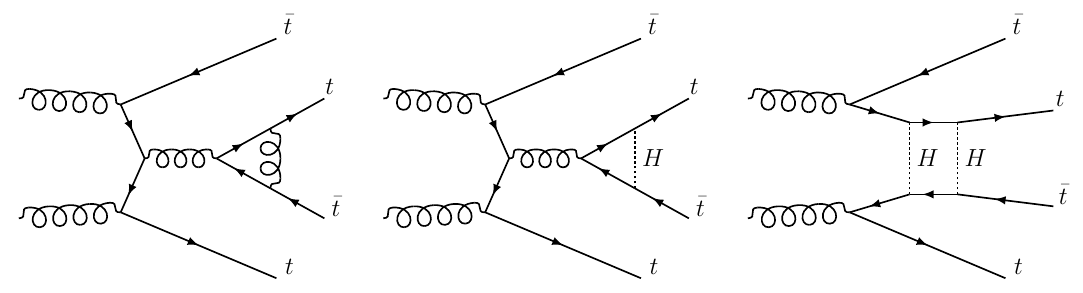
Figure 4 . Representative diagrams for the one-loop gg ! t (cid:22) tt (cid:22) t amplitude. The left diagram is of O ( (cid:11) 3 ), the central one is of O ( (cid:11) 2 (cid:11) ) and the right one is of O ( (cid:11) s (cid:11) 2 ). The interferences of these s s diagrams with those shown in (cid:12)gure 3 lead to contributions to NLO 1 , NLO 2 , NLO 3 and NLO 4